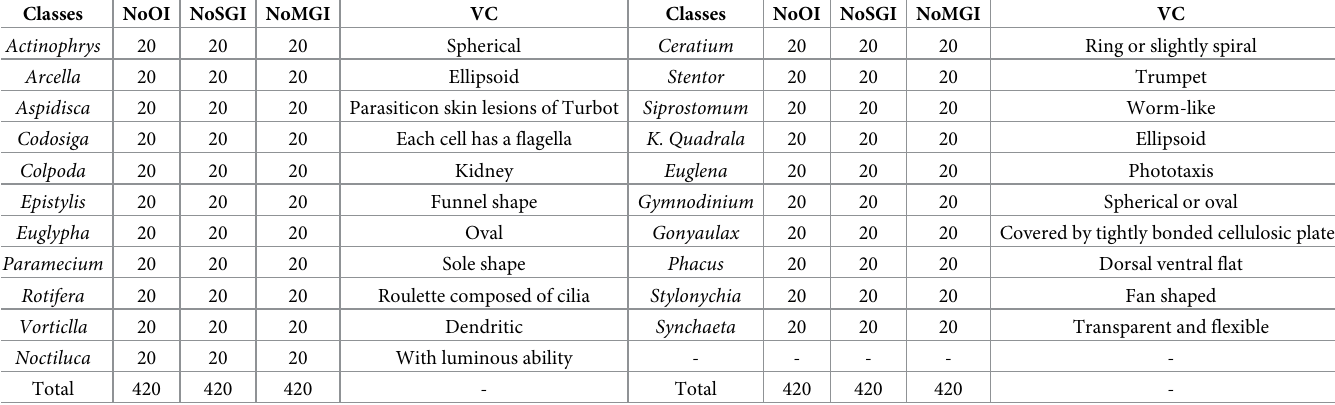
Table 1. Basic information of 21 EM classes in EMDS-5. Number of original images (NoOI), Number of single-object GT images (NoSGI), Number of multi-object GT images (NoMGI), Visible characteristics